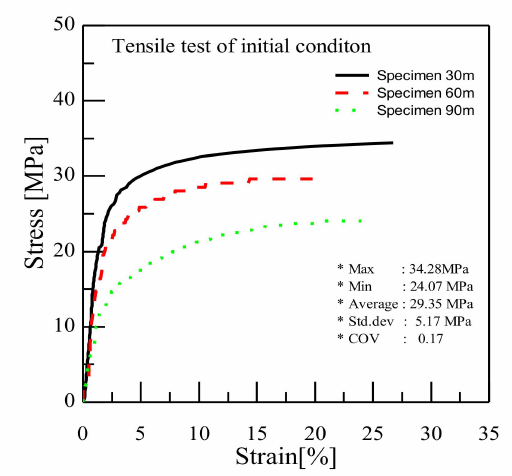
Figure 5. Results of the tensile test for initial condition CNT/PVDF